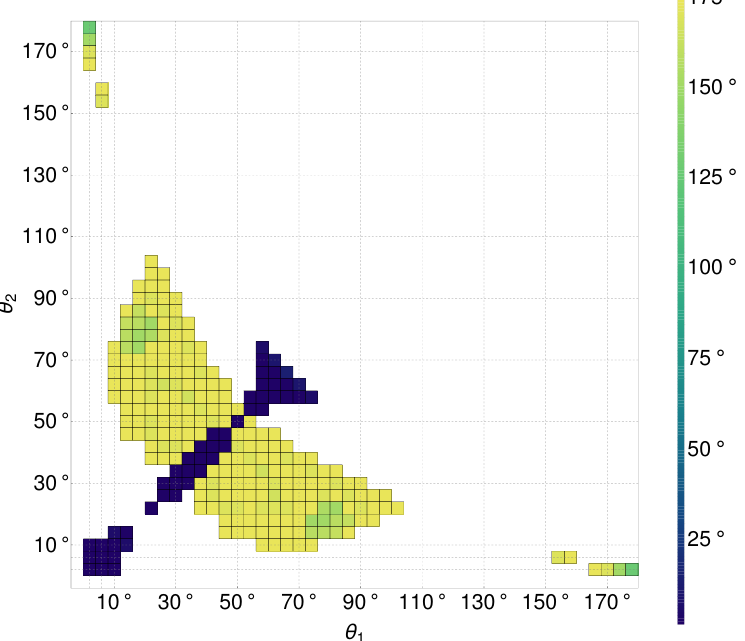
Figure 5: The distribution of the relative azimuthal angle ϕ responding to the maximal ∆ SIGS in the cross section distribution (see Fig. 4) for the deuteron breakup process at E = 65